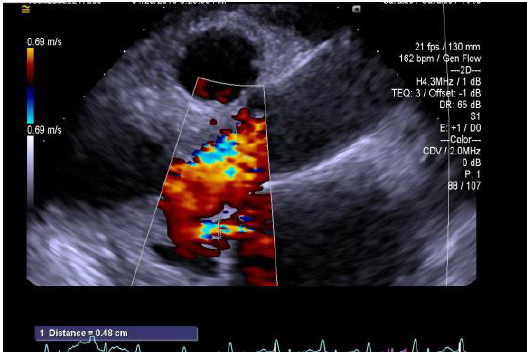
Figure 2 . Trans esophageal echocardiography severe